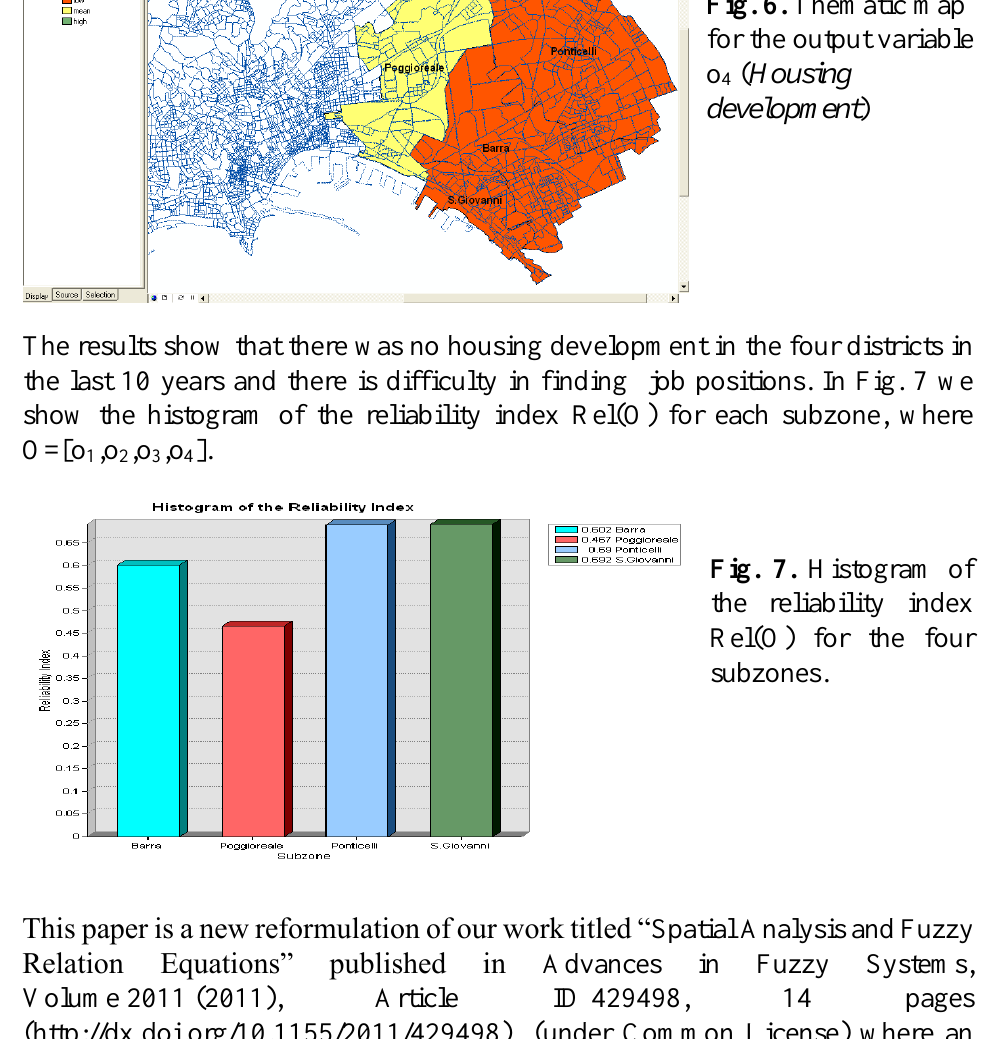
Fig. 6. Thematic map for the output variable o ( Housing 4 development )